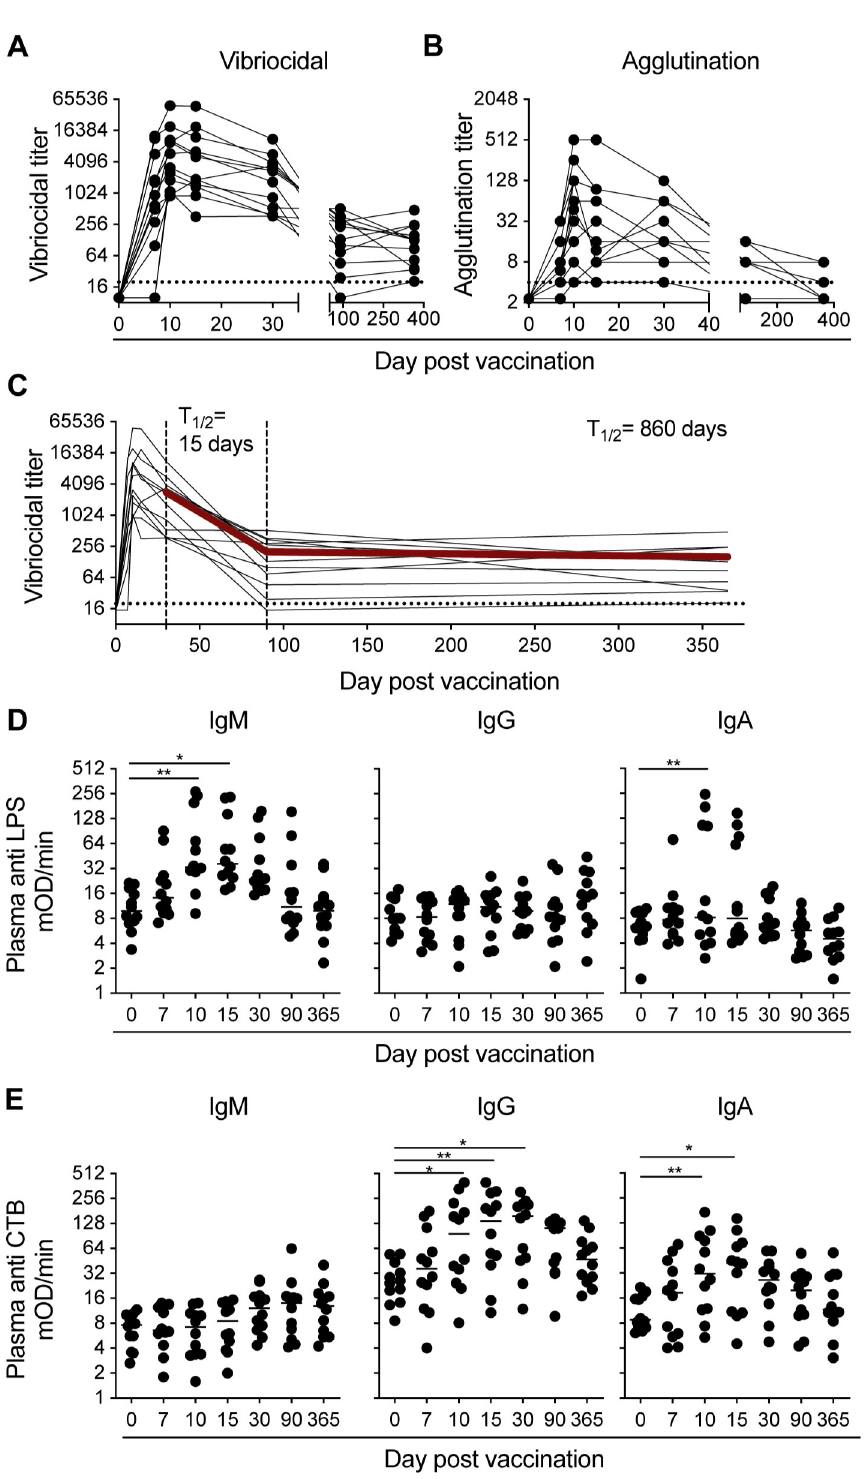
Fig 1. V . cholerae specific plasma antibody titers rise rapidly following vaccination and are maintained at least for one year post vaccination. (A) Vibriocidal and (B) Agglutination titers on day 0, 7, 10, 15, 30, 90, and 365 for each of the 12 subjects following vaccination. Dotted line in the vibriocidal and agglutination figures indicate the lowest dilution of serum tested in the assay. (C) Longitudinal vibriocidal titers measured for each of the 12 subjects following vaccination from day 0 to day 365. Half-life (T ½ ) estimated by an exponential decay model using the average